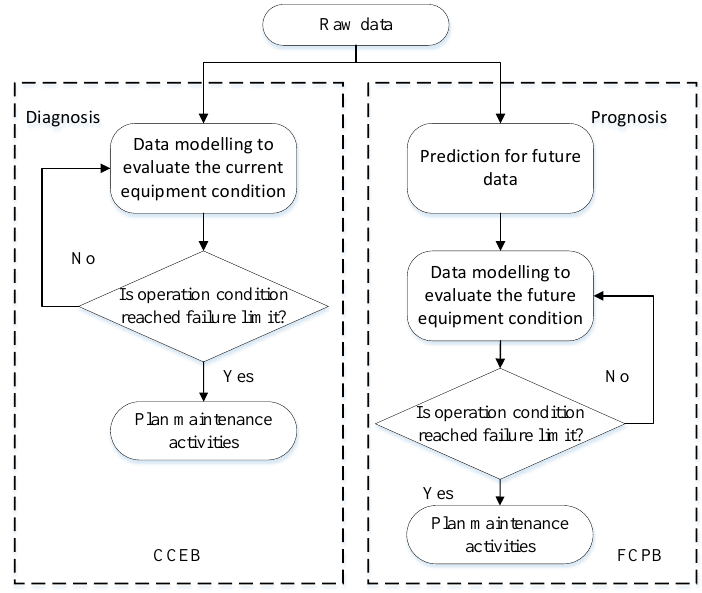
Figure 10. Typical decision framework of CCEB and FCPB.